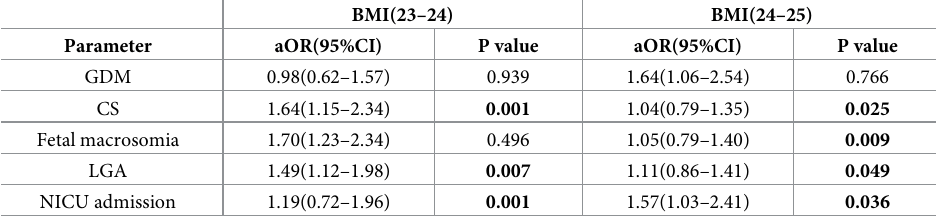
Table 9. Comparisons of adverse perinatal outcomes between target BMI group (BMI of 26–27) and BMI reduc- tion group.